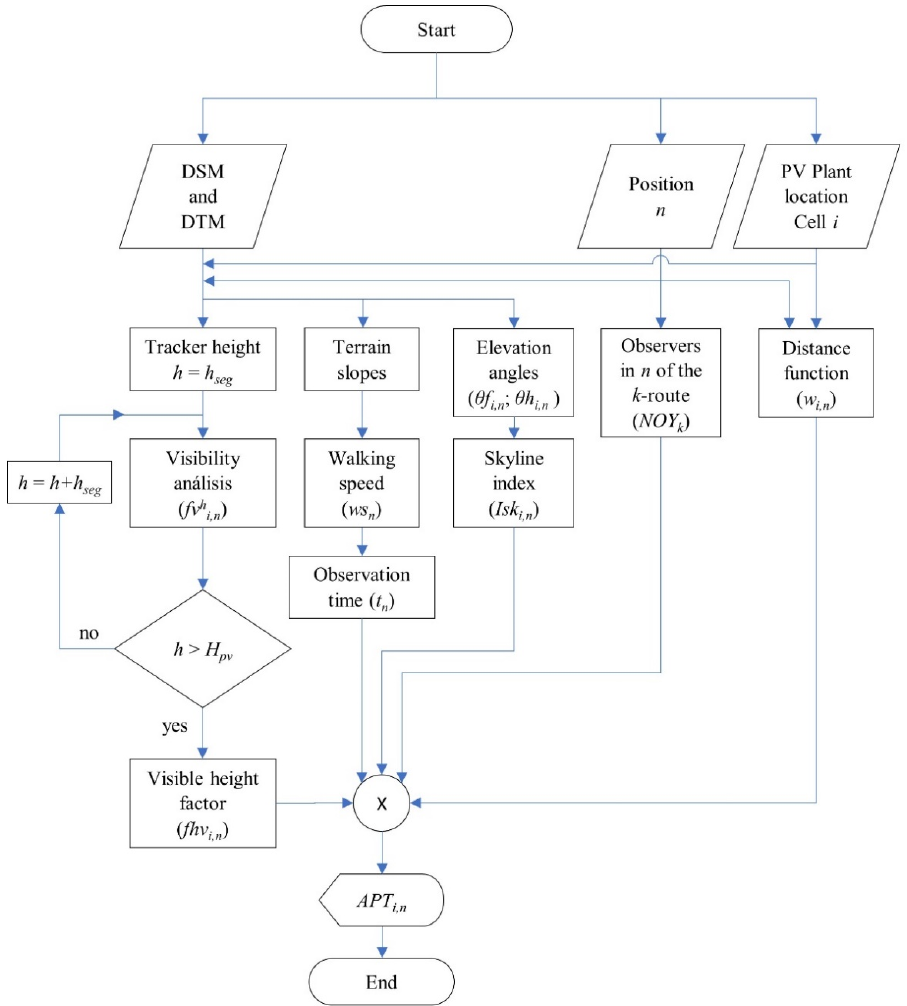
Figure 2. APT i,n calculation flow-chart for PV plant placed in the area represented by cell i , and observers in the position represented by node n .